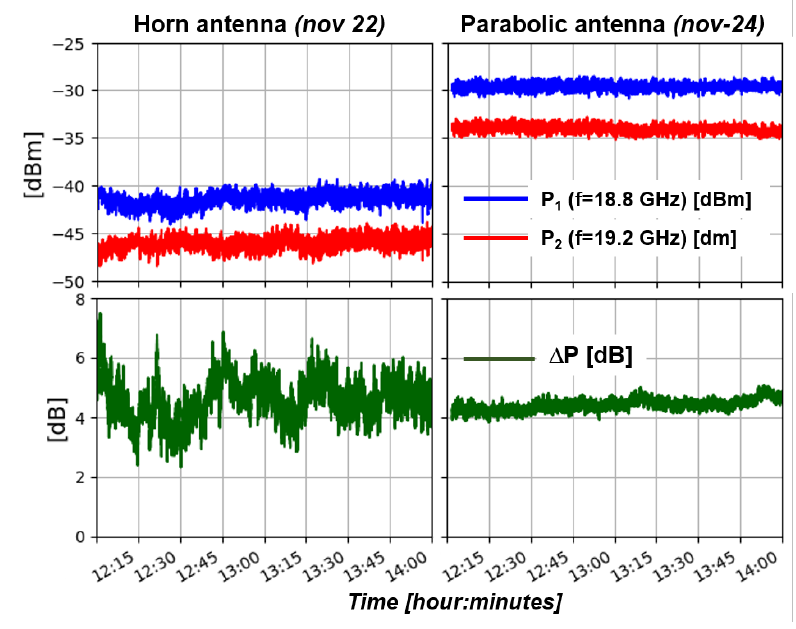
Figure 3. Comparison between measurements performed with different receiving